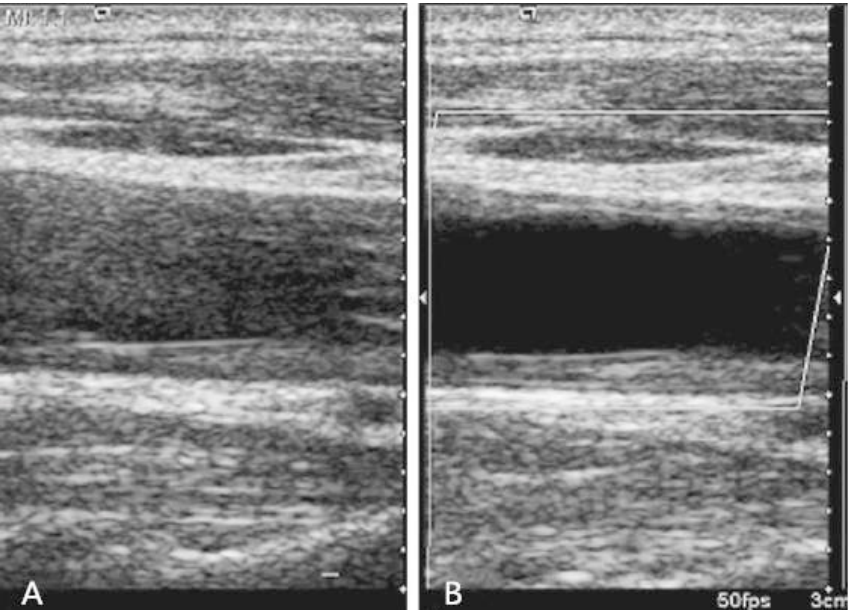
Figure 1 - Grayscale 2D ultrasound shows an obscured anterior wall and sound artifacts in the lumen (A), while a VET image shows a clear lumen and a thickened endo-medial tunica of the anterior and posterior wall